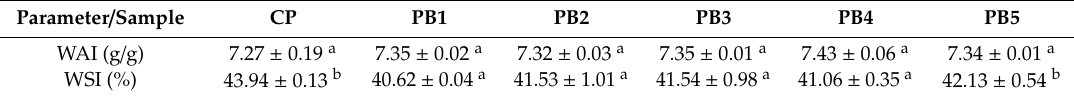
Table 3. Results of hydration properties of the raw pasta